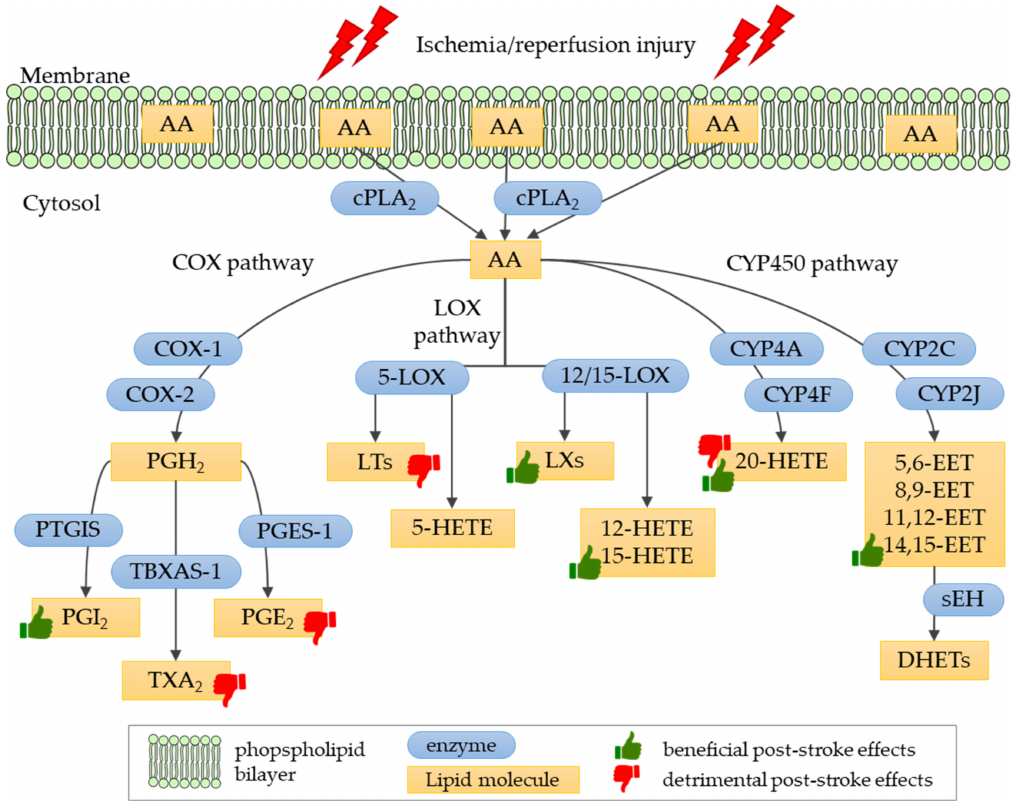
Figure 2. Eicosanoid biosynthesis pathways. Enzymes involved in biosynthetic pathways are denoted as: cPLA 2 , cytosolic phospholipase A 2 ; COX-1, cyclooxygenase 1; COX-2, cyclooxygenase 2; PGIS, prostaglandin-I synthase; TBXAS-1, thromboxane-A synthase; PGES-1, prostaglandin E synthase; 12 / 15-LOX, 12 / 15-lipoxygenase; 5-LOX, 5-lipoxygenase; CYP4A, cytochrome P450 4A subfamily; CYP4F, cytochrome P450 4F subfamily; CYP2C, cytochrome P450 2C subfamily; CYP2J, cytochrome P450 2J subfamily; sEH, soluble epoxide hydrolase. Lipid molecules generated in biosynthesis are denoted as: AA,arachidonicacid; PGH 2 , prostaglandinH 2 ; PGI 2 , prostaglandinI 2 , prostacyclin; TXA 2 , thromboxane A 2 ; PGE 2 , prostaglandin E 2 ; LTs, leukotrienes; 5-HETE, 5-hydroxyeicosatetraenoic acid; LXs, lipoxins; 12-HETE, 12-hydroxyeicosatetraenoic acid; 15-HETE, 15-hydroxyeicosatetraenoic acid; 20-HETE, 20-hydroxyeicosatetraenoic acid; 5,6-EET, 5,6-epoxyeicosatrienoic acid; 8,9-EET, 8,9-epoxyeicosatrienoic acid; 11,12-EET, 11,12-epoxyeicosatrienoic acid; 14,15-EET, 14,15-epoxyeicosatrienoic acid; DHETs, dihydroxyeicosatrienoic acids. Thumb symbol denotes beneficial or detrimental e ff ects on the post-stroke brain of eicosanoids discussed in this